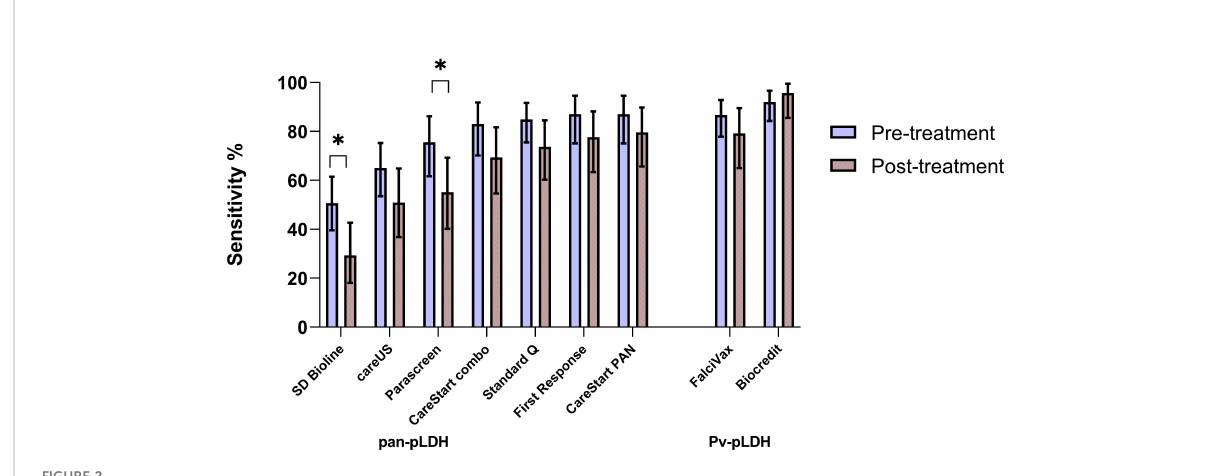
FIGURE 2 Comparative sensitivity of RDT targets (pre versus post antimalarial treatment) for P. knowlesi including 95% con fi dence intervals (*) indicate p <